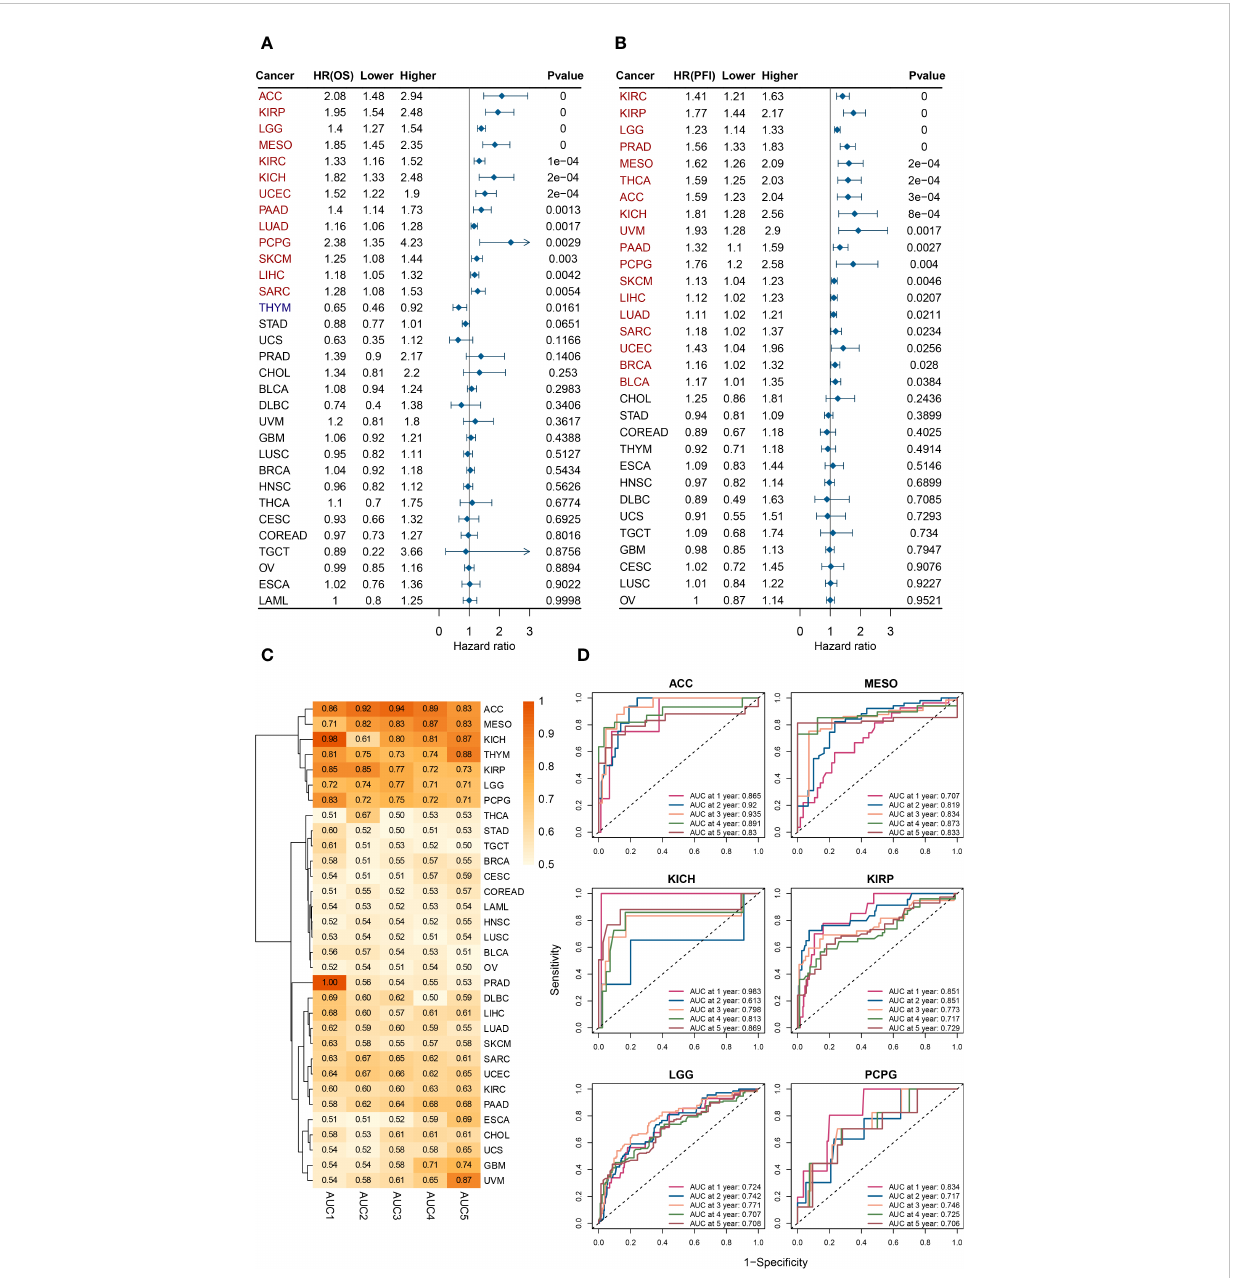
FIGURE 2 ESPL1 expression correlates with patient prognosis. Forest plot of associations between ESPL1 expression and (A) OS and (B) PFI. (C) Heat map of AUC of ESPL1 expression to predict patient prognosis from 1 to 5 years. (D) ROC of ESPL1 expression to predict prognosis in ACC, MESO, KICH, KIRP, LGG and PCPG. OS, overall survival; PFI, Progression Free Interval; AUC, Area Under Curve; ROC, Receiver Operating